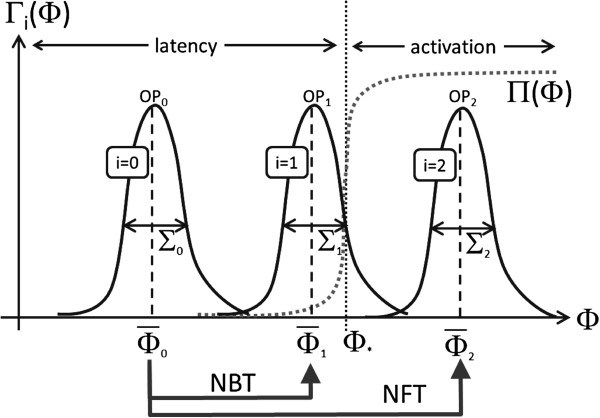
The meaning of the noise-free and the noise-based activations. The figure illustrates the meaning behind the noise-free and noise-based activations. All graphs were drawn by hand. Γi(Φ) with i=0,1,2 are distribution functions for the observable Φ for three systems in three operating points: the latent cell i=0, the cell that has been activated using the noise-based therapy (i=1), and the cell that has been activated using noise-free therapy (i=2). Φ¯i and Σi are the means and the standard deviations. The noise free therapy (NFT) shifts the operating point of the virus from the stable (latent) operating point OP0 to the operating point OP2. This almost certainly activates the virus since Φ¯2−κΣ2≫Φ∗. The noise-based therapy (NBT) induces the shift from the OP0 to the operating point OP1 where the activation is less certain but still possible since the tail of the Γ1 enters into the activation region and Φ¯1+κΣ1≈Φ∗. Variable κ is a numerical factor close to 1.